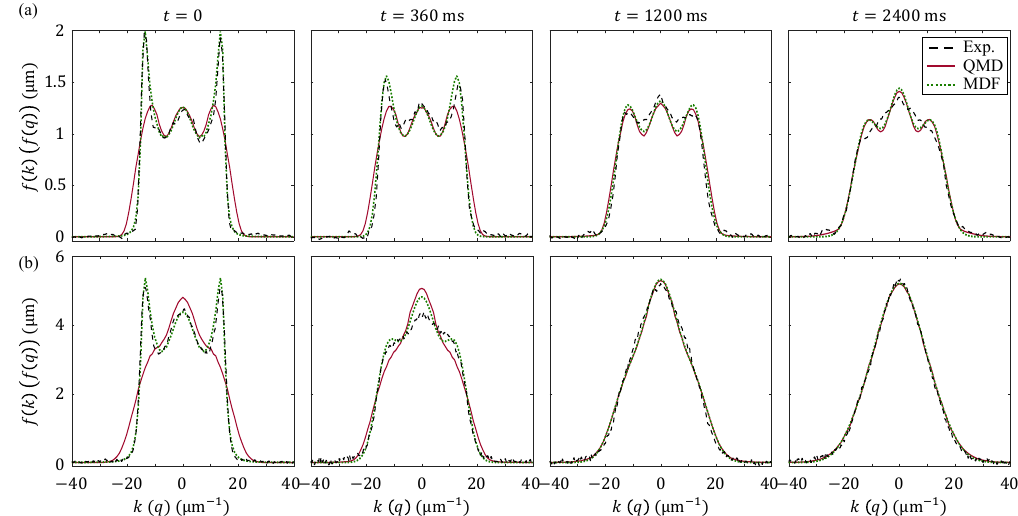
Figure 8: Estimation of oscillation period averaged MDF for (a) N = 40 and (b) N = 130. For comparison purposes, we estimate the MDFs (green dotted curves) from the quasimomentum distributions (QMD) calculated in MD simulations (red solid curves) and observe good agreement with the experimentally measured profiles (black dashed curves). As the 1D gases approach the non-degenerate limit, the MDF and QMD tend to